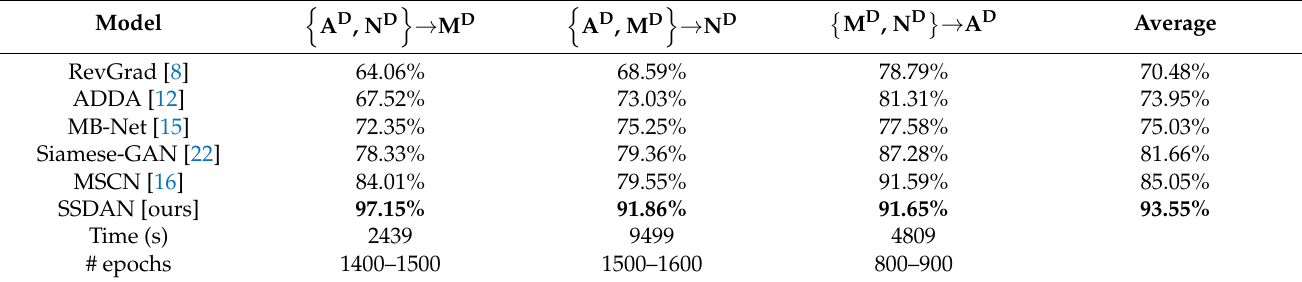
Table 4. OA results for the two-source scenarios and comparison to state-of-the-art methods.